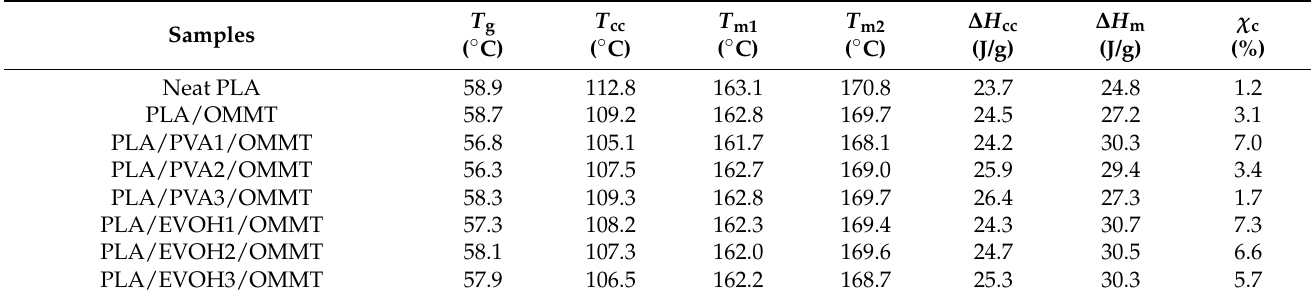
Figure 3. DSC curves for the second heating scan of ( a ) PLA/PVA/OMMT composites and ( b ) PLA/EVOH/OMMT composites. Table 3. Thermal properties and crystallinity of the PLA/PVA/OMMT and PLA/EVOH/OMMT composites obtained from the DSC